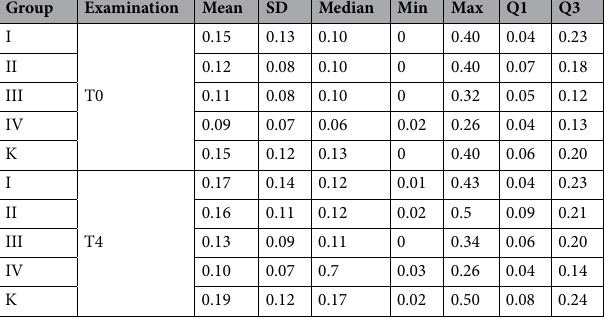
Table 4. Basic descriptive statistics of T0, T4 DMFs values (Time) by a grouping variable (Group).